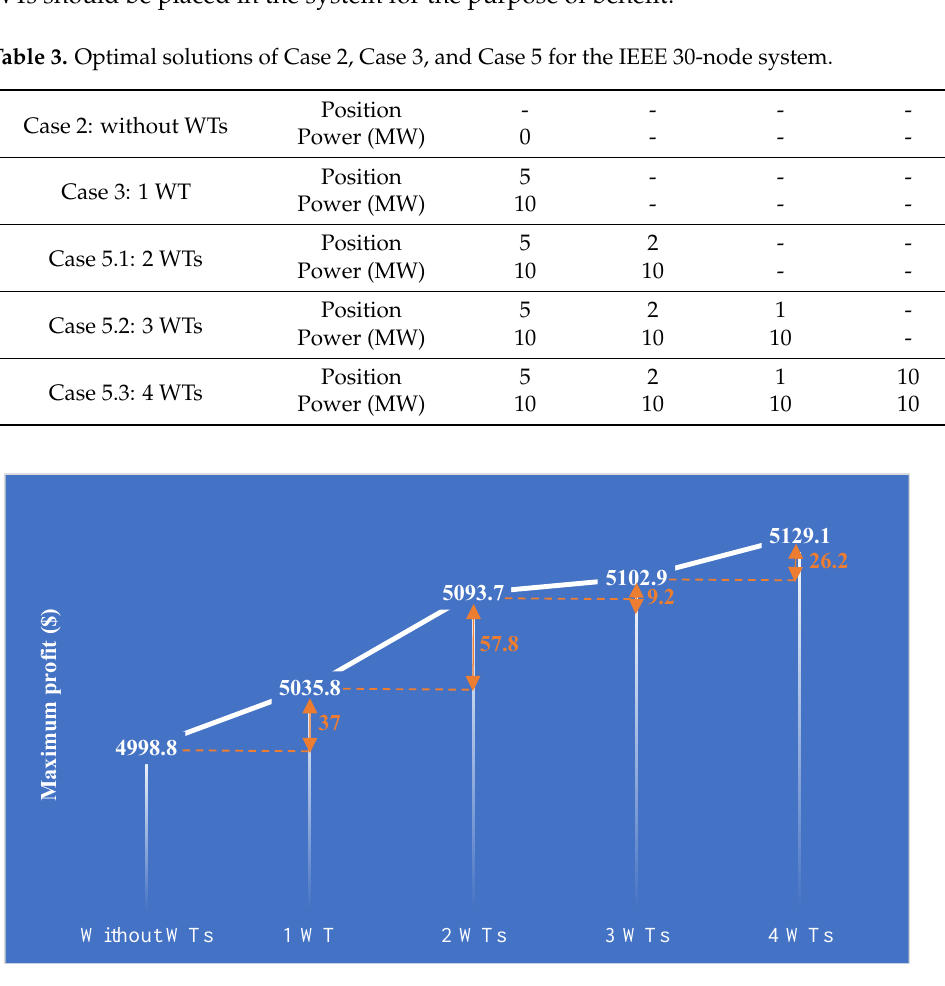
Table 4. Optimal solutions for the IEEE 118-node system.